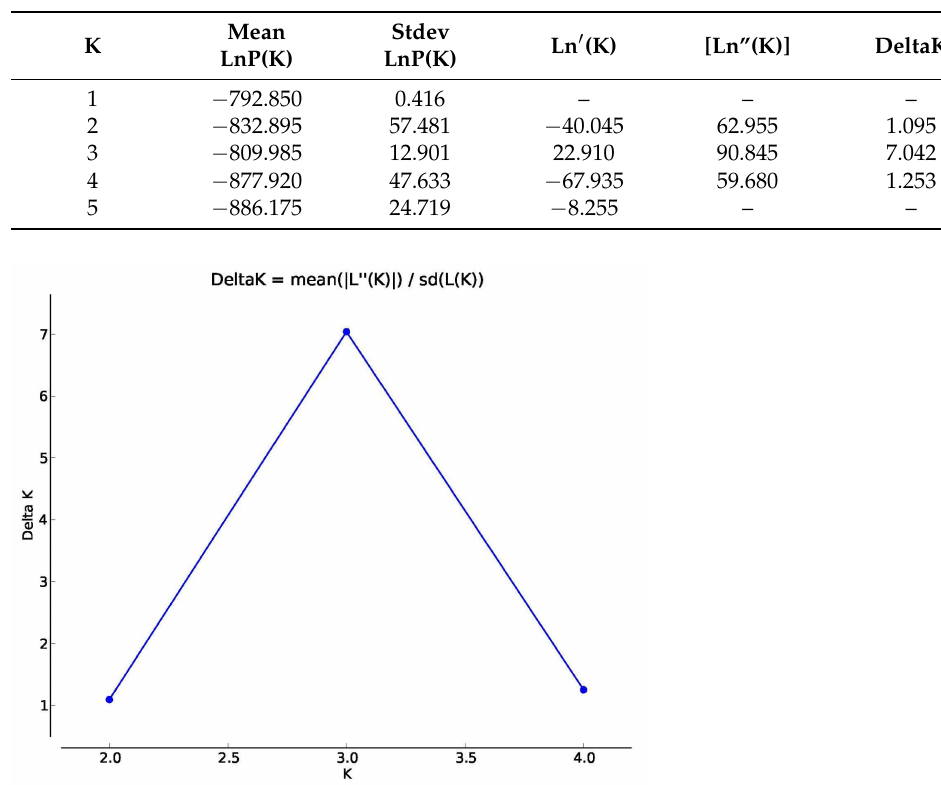
Figure 4. Principle coordinate analysis (BPK= Big Pine Key; ZM = Zoo Miami; DJ = Dagny Johnson) showing two populations connected by genetic similarity. Table 2. Structure results of population clustering.